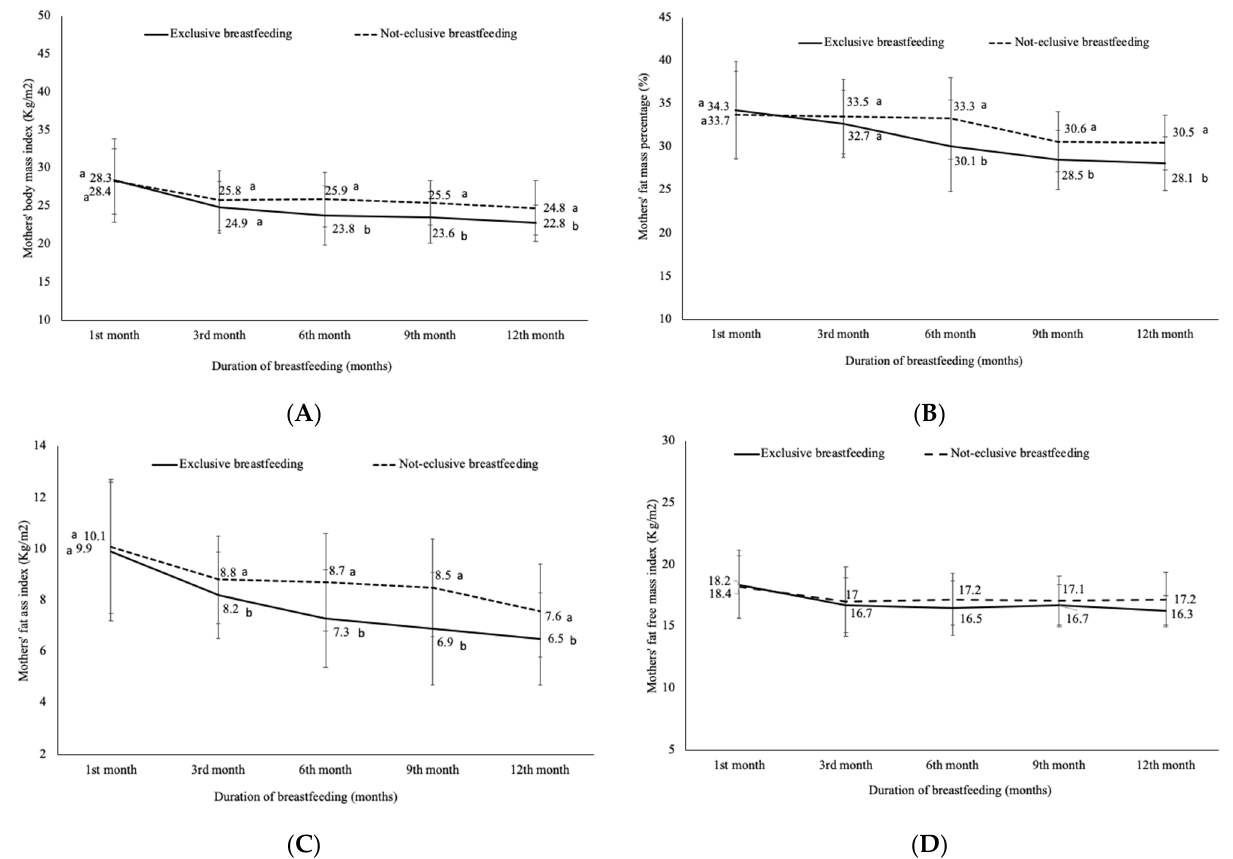
Figure 4. Longitudinal changes in: ( A ) mothers’ body mass index, ( B ) mothers’ fat mass percentage, ( C ) mothers’ fat mass index and ( D ) mothers’ fat free mass index during one year after delivery according to the breastfeeding pattern. BMI: body mass index in kg/m 2 ; FM%: fat mass percentage; FMI: fat mass index in kg/m 2 ; FFMI: fat free mass index kg/m 2 ; a, b: represent the significance level (values with the same letters are statistically not different however, the values with different letters are statistically different) of the comparison at each point time.